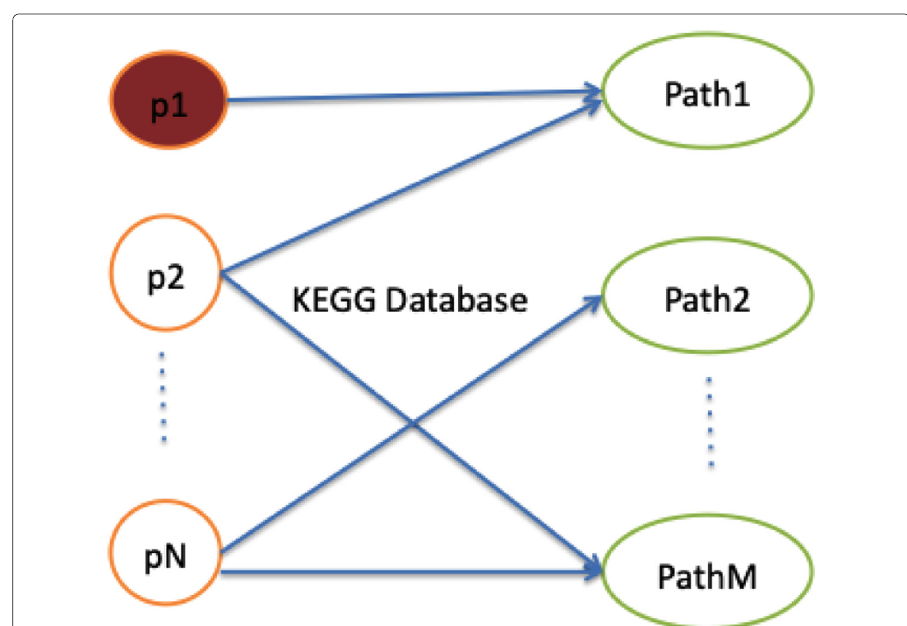
Fig. 14 The private affiliation network extracted from the KEGG database: private proteins connected to pathway identifiers